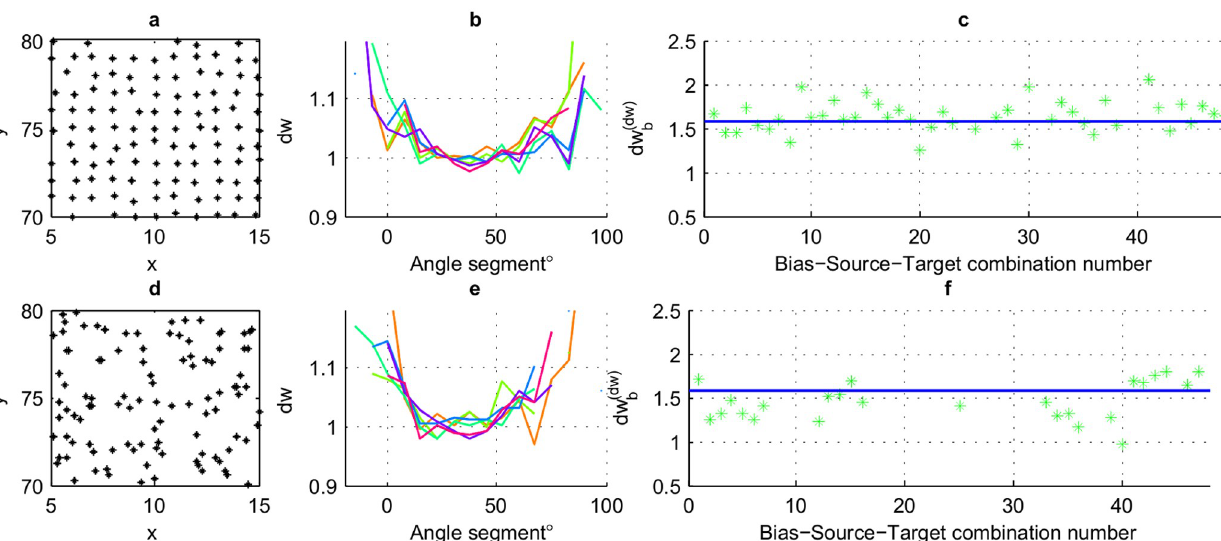
Fig 5. Obtaining dw from dw . (a), (d) Initializations of networks having noise levels of 0.1 and 0.7 respectively. (b), (e) Dependence of dw on the relative b angle of the line connecting the source and target to the direction of bias for 6 initializations of networks with noise levels same as leftmost figures in each line. (c), (f) The relationship of dw to dw obtained empirically, for network on the left, through comparing the values calculated for dw obtained using Eq 7 with b the optimal dw b obtained using Eq 8. The values are taken from 48 Bias-Source-Target combinations for each network. MFPT � ( MFPT taking FPT = L for misses) and MFPT r ( MFPT given the target is reached) is